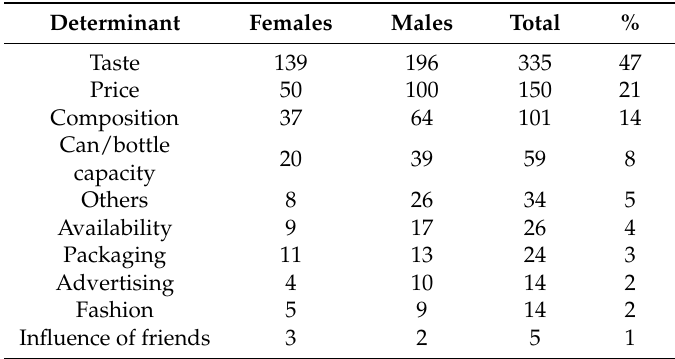
Table 4. Determinants affecting the purchase of EDs by adolescent